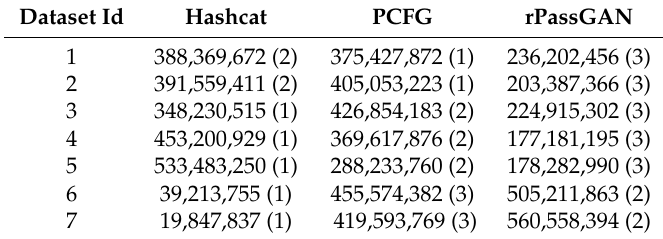
Table 3. Number of candidate of each model consisting of REDPACK candidates. Number in parenthesis denotes cracking performance rank among input